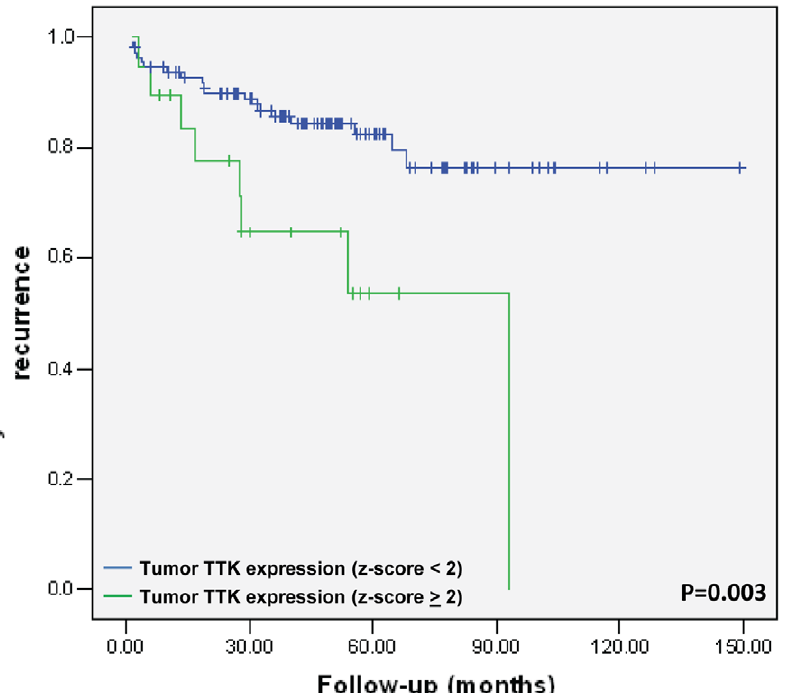
Figure 3. Higher TTK expression is associated with biochemical recurrence. Kaplan Meier plot of the risk of biochemical recurrence in patients (n=131) with TTK overexpressing prostate tumors (n=20; green line) versus those without TTK overexpressing (n=111; blue line) tumors (p=0.003, log-rank test).